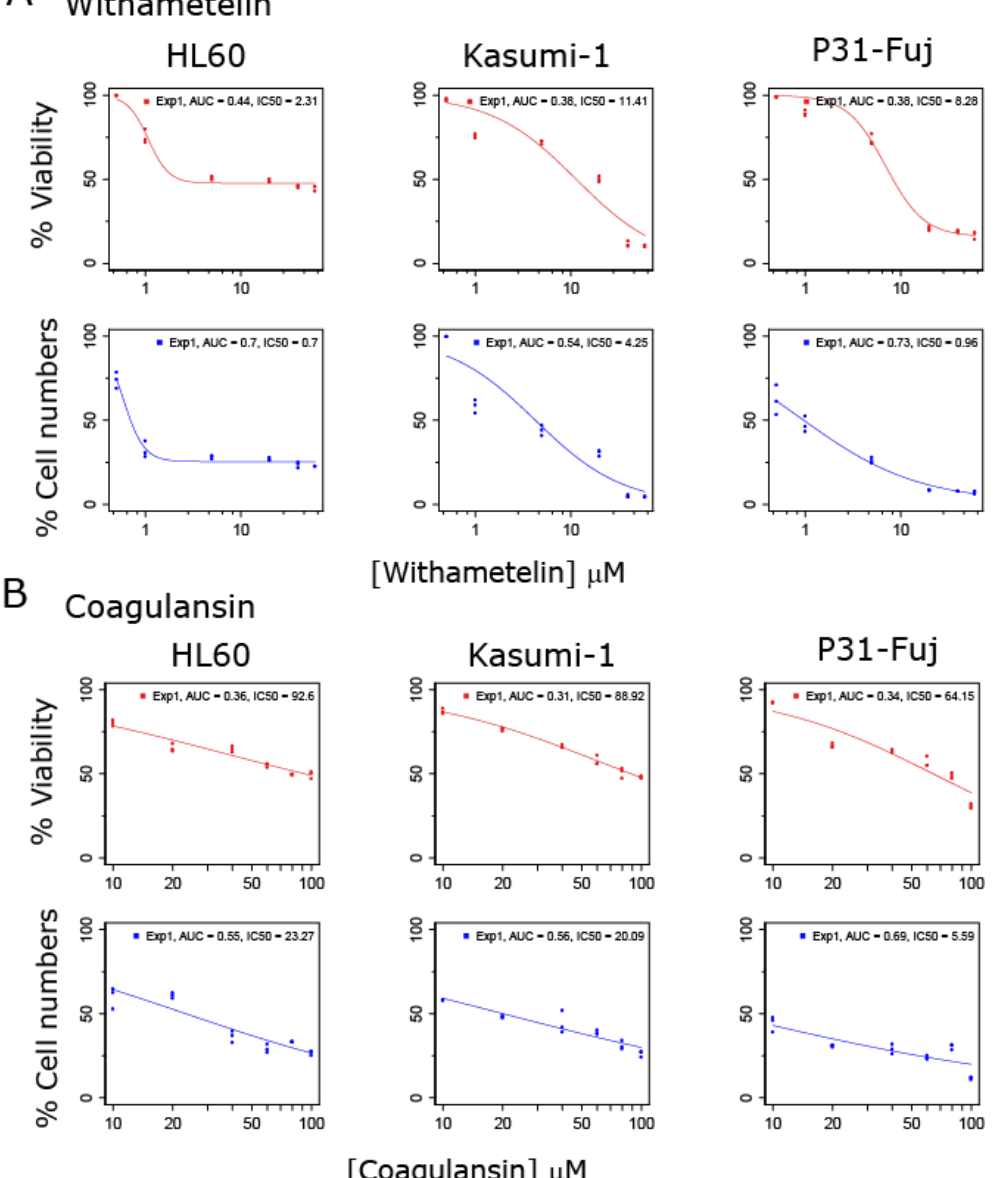
Figure 1. Impact of withanolides in reducing cell viability and proliferation of acute myeloid leukemia (AML) cell models. Percentage of viable cells and number of cells relative to control was determined as a function of treatment with withametelin (WTH) ( A ) or coagulansin A (CoA) ( B ) in the named cell lines. IC 50 was determined using the pharmacoGx package in R.